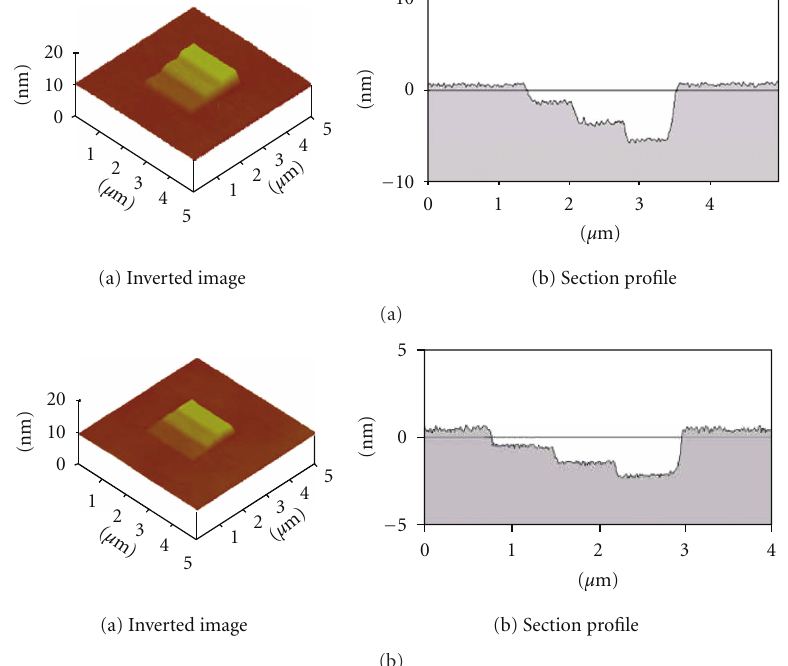
Figure 14: Three-step grooves on the nanoperiod multilayer films. (a) CN/BN 4-nm-period film; processing loads of 40, 50, 70 µ N from left to right. (b) CN/BN 2-nm-period film; processing loads of 10, 15, 20 µ N from left to